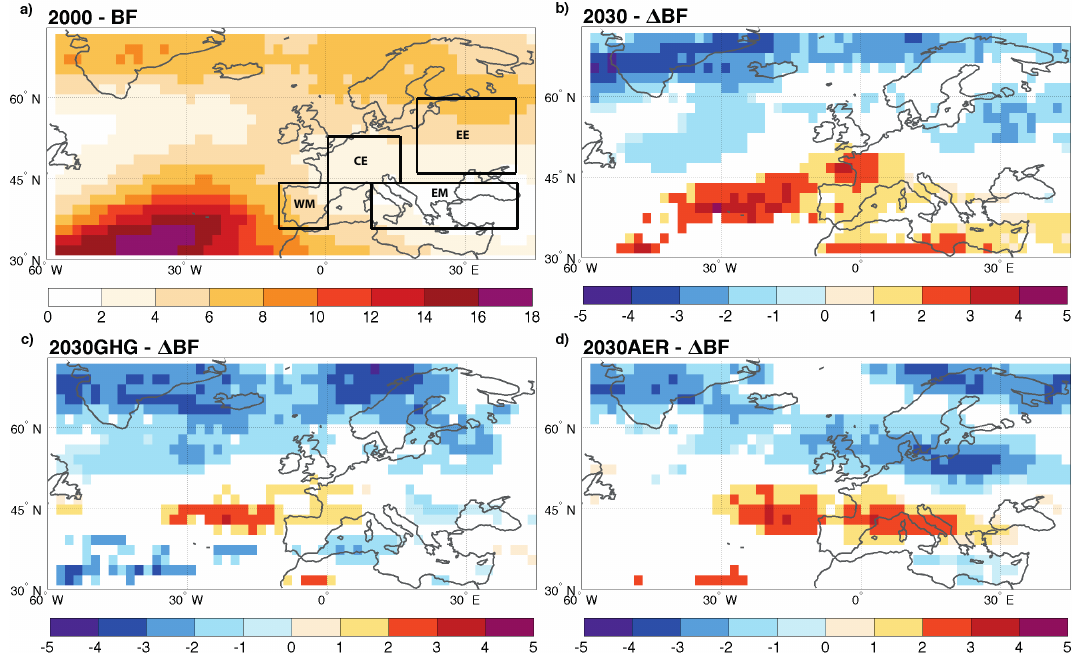
Figure 3. Blocking frequency (in % of days in which a blocking event occurs at a given gridbox) over the Atlantic sector for the 2000 simulation (a) ; changes in blocking frequency compared to the 2000 simulation for 2030 (b) , 2030GHG (c) and 2030AER (d) simulations in winter (DJF). Only areas in which the difference between the 2000 control and the sensitivity simulation is significant at 95% confidence level are shaded (in white non-significant areas). In panel (a) we have highlighted the regions discussed in Sect. 3.3 and Table 2.